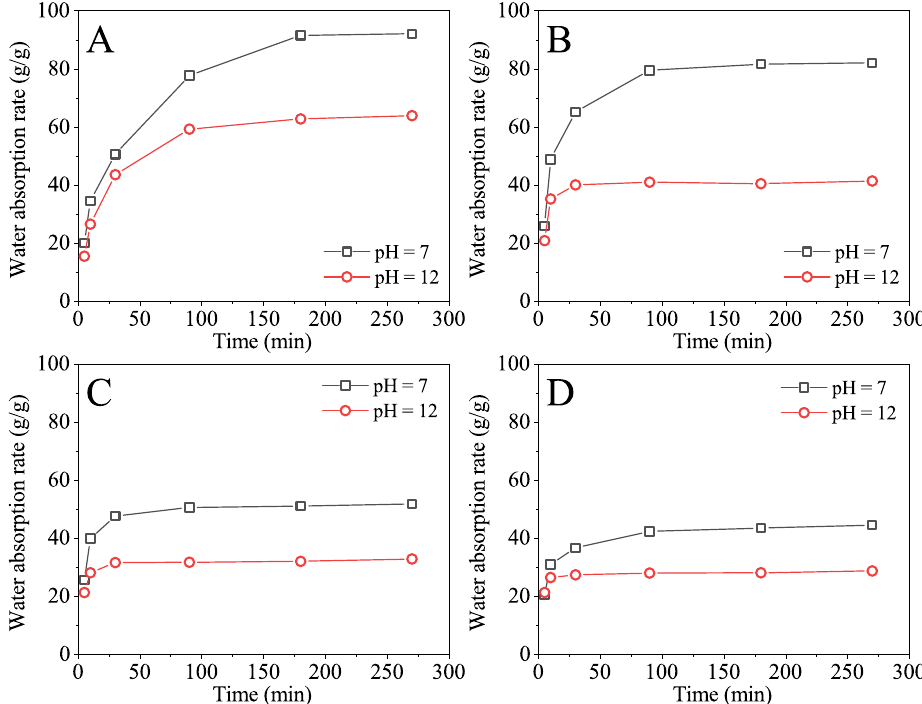
Figure 2. The absorption rates of SAPs prepared with different MBA dosages tested at 90 ◦ C in water (pH = 7) and in NaOH solution (pH = 12) varied with time; the MBA dosages are ( A ) 0.143%, ( B ) 0.429%, ( C ) 0.715%, and ( D )